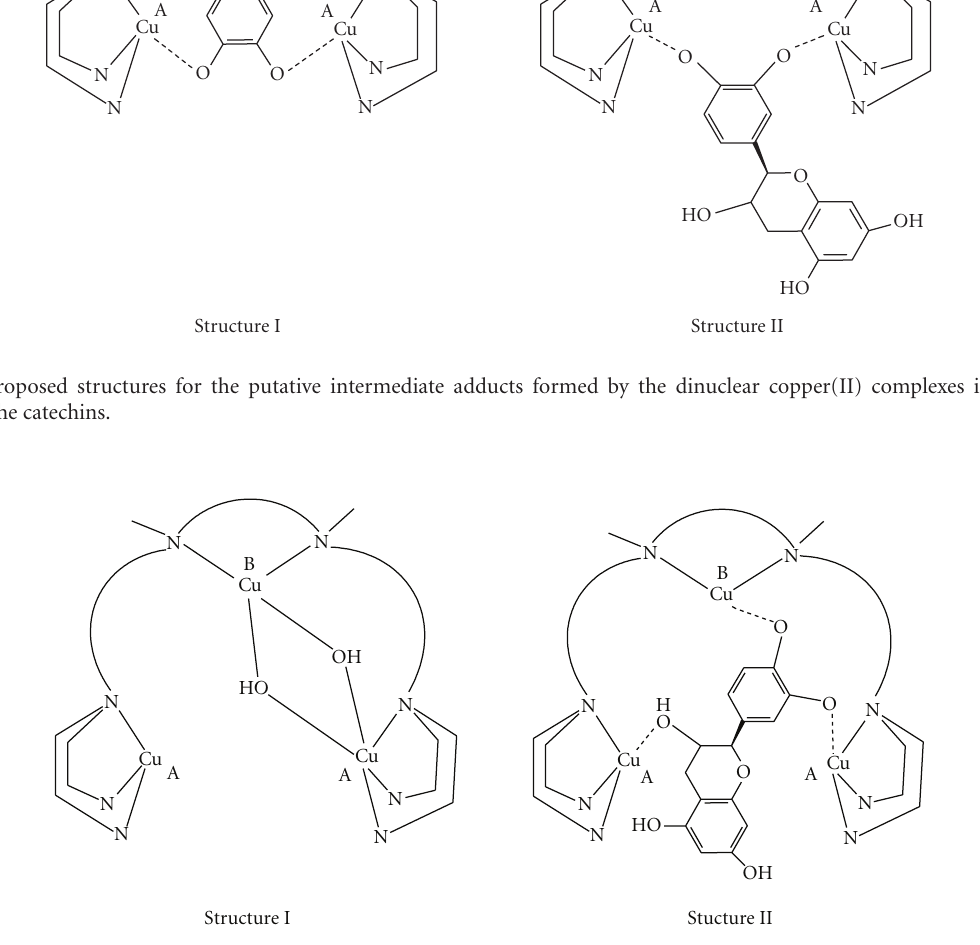
Scheme 3: Proposed structures for the trinuclear copper(II) complexes (I) and for the putative intermediate adducts (II) with the